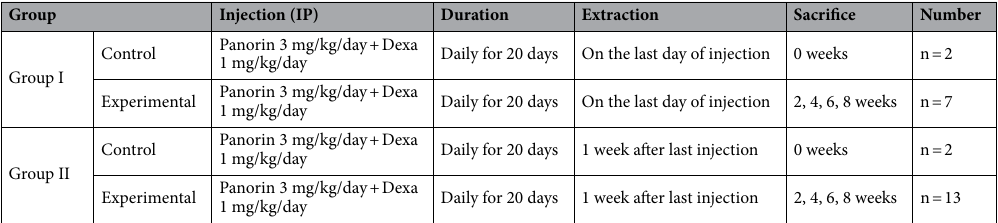
Table 2. Animal grouping for the intraperitoneal injection model. The animals were divided into group I and group II.